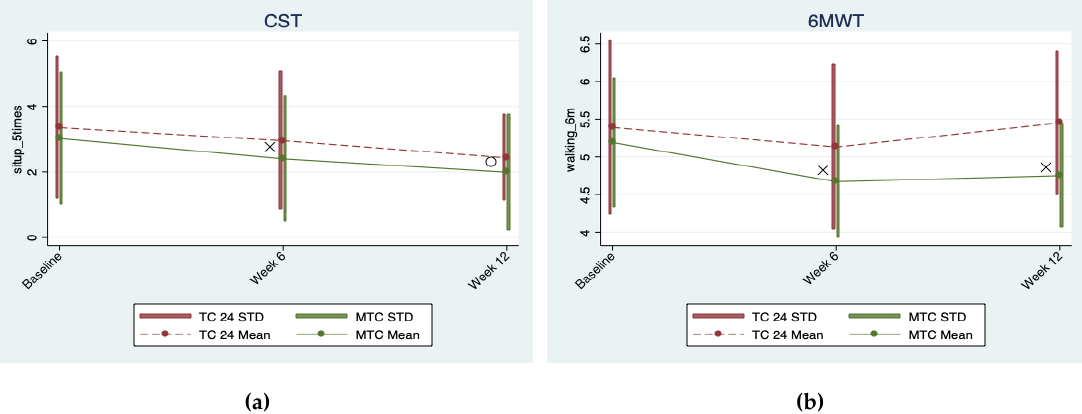
Figure 4. Interaction plots for indices (( a ) CST and ( b ) 6MWT)) of physical fitness.